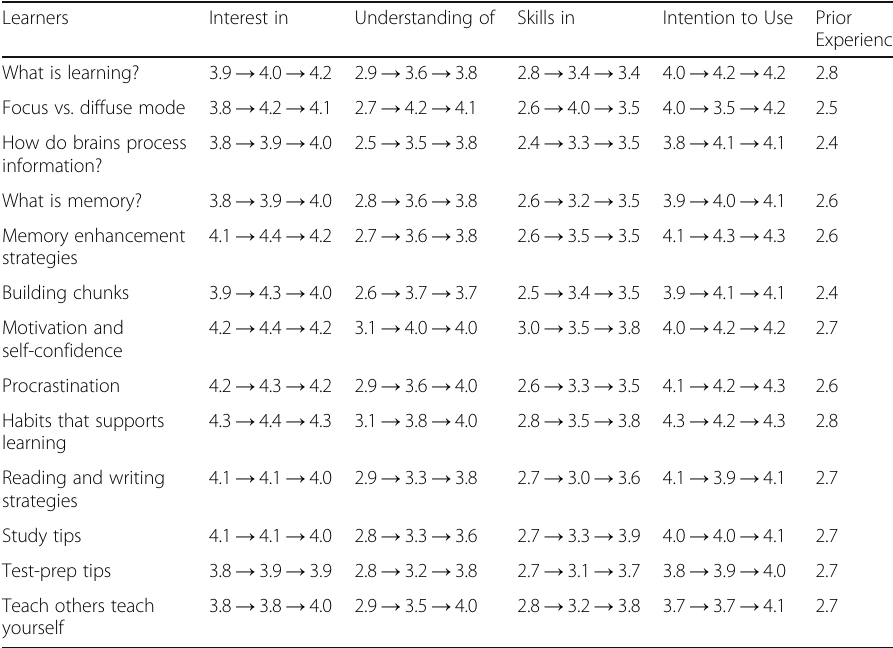
Table 7 Chinese students ’ self-report about what they gained from TOL (5-point Likert; entrance → midterm → final; n = 271 → 80 →